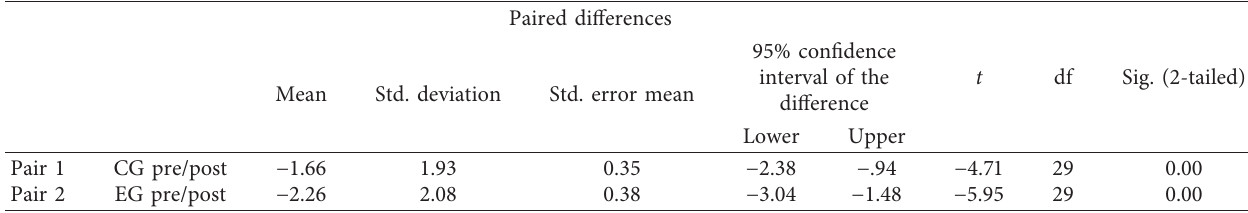
t df Sig. (2-tailed)